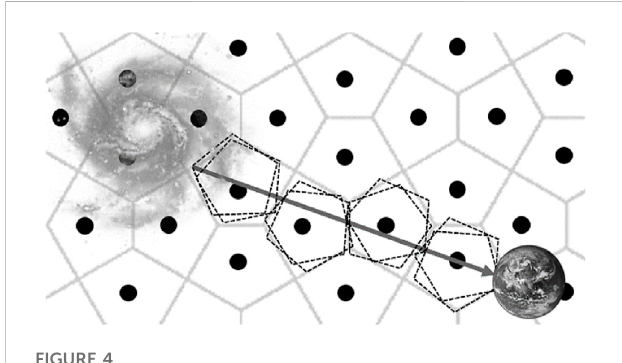
FIGURE 4 SchematizationoftheIGMmadeofaWigner – Seitzelectron crystal grid through which photons of light travel. The arrow represents the photon path. Dotted lines characterize the harmonic motion performed by each crystal for a photon transit. The observed wavelength is redshifted compared to the emitted